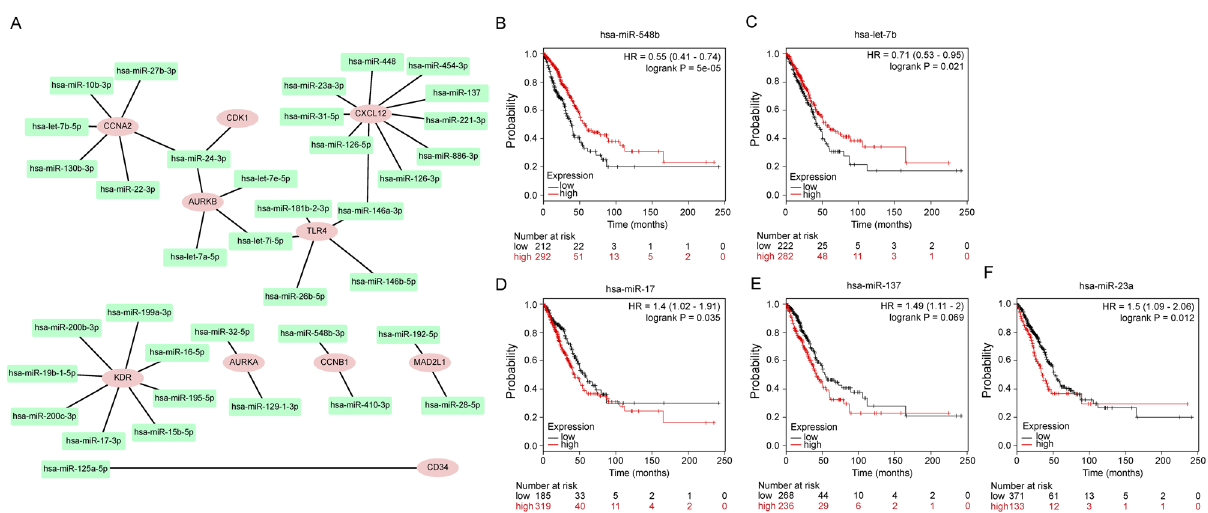
Figure 5. Construction of miRNA-gene network using Cytoscape software. ( A ) The rectangle in the network represents miRNA. The ellipse in the network represents hub genes. ( B – F ) Representative prognostic value of key miRNAs validated using Kaplan–Meier plotter